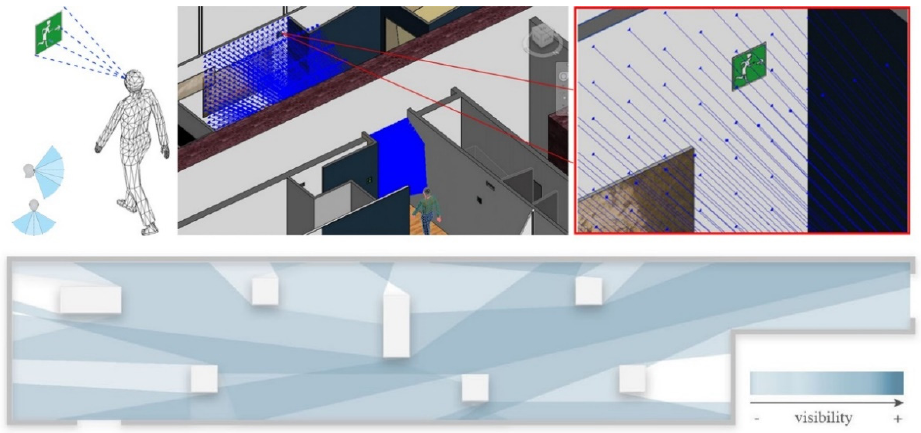
Figure 7. Verification of the safety signal visibility in the BIM environment. Orthographic and spatial